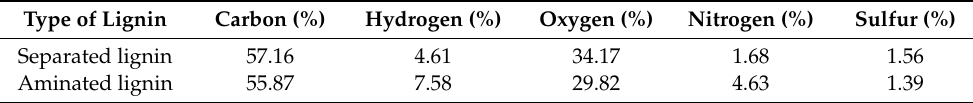
Table 1. CHNS analyses of lignin before and after amination.